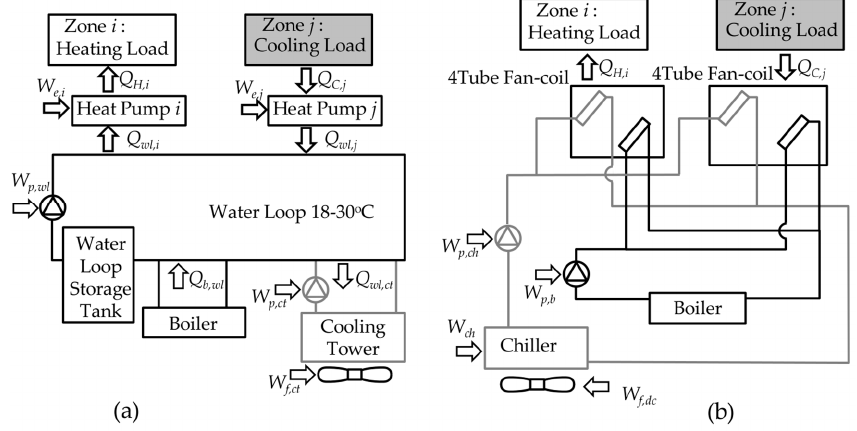
Figure 2. ( a ) Water Loop Heat Pump (WLHP) system; ( b ) 4-Tube fan-coil water heating, ventilation